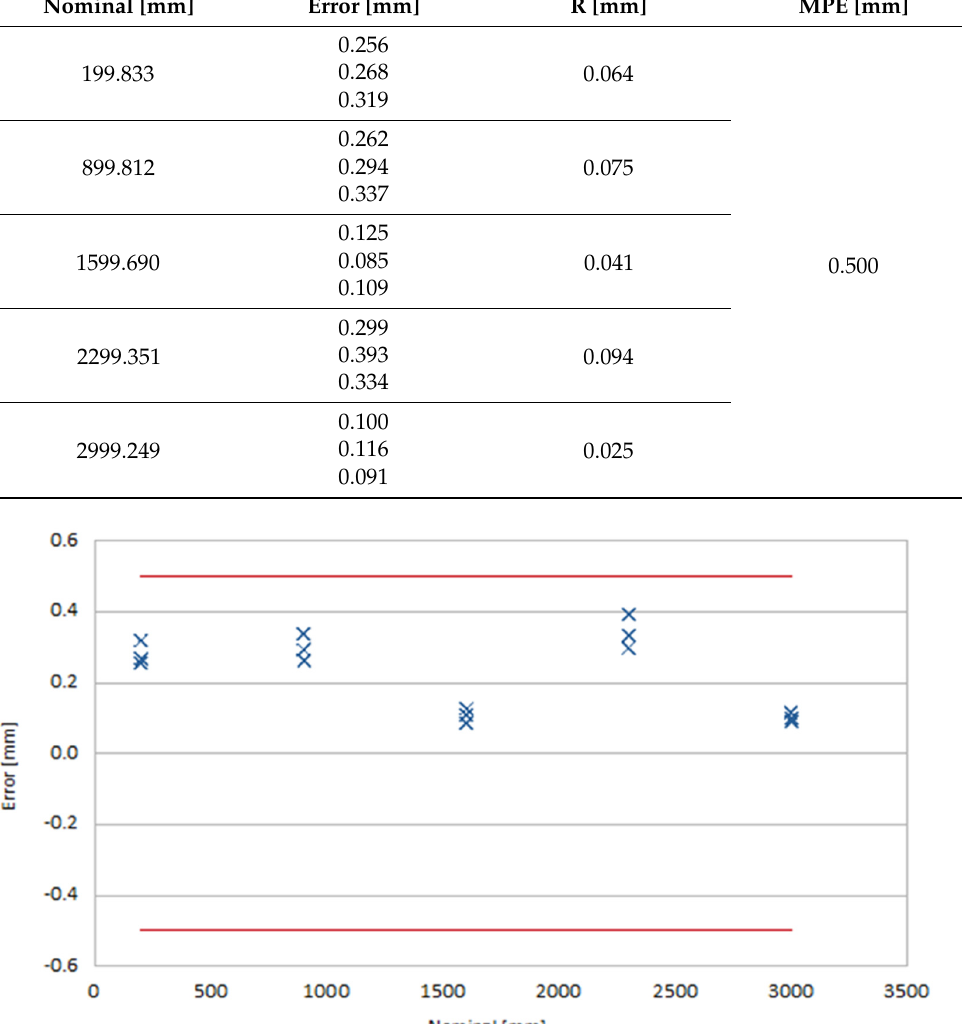
Figure 7. X − axis measurement error characteristic. Table 3. Measurement errors of the Z-axis (vertical direction).